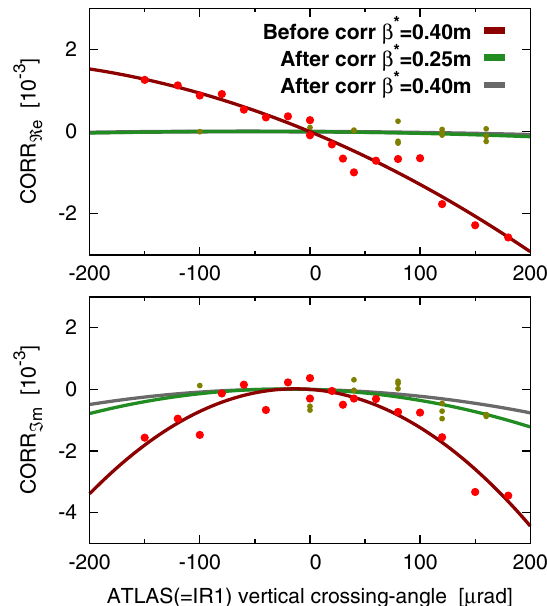
FIG. 18. Required global coupling correction [70] of Beam 2 as a function of vertical crossing angle in the ATLAS (IR1) insertion. Measurements before normal sextupole and skew octupole correction are for β (cid:1) ¼ 0 . 4 m (red), and after correction for β (cid:1) ¼ 0 . 25 m (green). The postcorrection measurement extrapolated to β (cid:1) ¼ 0 . 4 m is shown (gray). The correction q ffiffiffiffiffiffiffiffiffiffiffiffiffiffiffiffiffiffiffiffiffiffiffiffiffiffiffiffiffiffiffiffiffiffiffiffiffiffiffiffiffiffi where CORR 2 ℜ e þ CORR 2 ℑ m strength is defined as j C − j ¼ CORR ℜ e and CORR ℑ m are skew-quadrupole knobs acting FIG. 19. Beam- and model-based correction for normal sextu- orthogonally on the real and imaginary parts of f 1001 at a specific pole errors in the ATLAS IR (IR1), compared to the expected corrections based upon magnetic location in the ring [70].